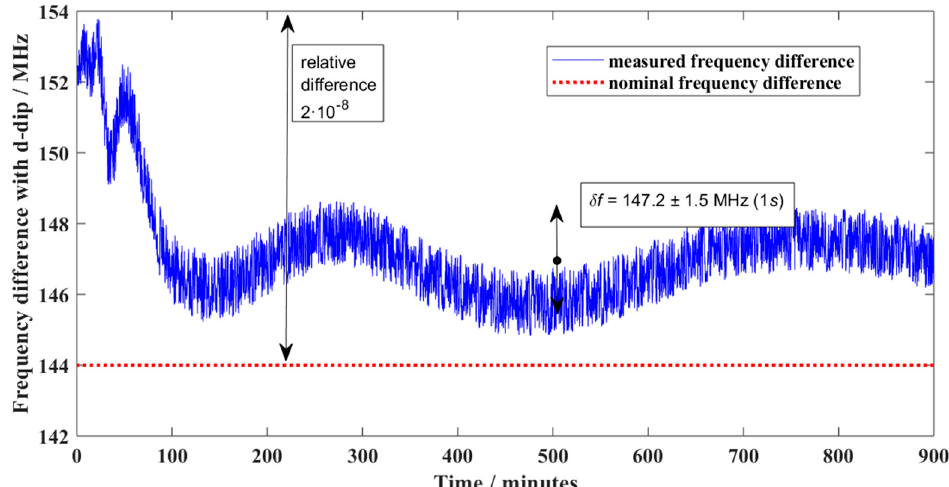
Figure 3. Typical result of a beat-measurement between an iodine stabilized laser and a laser used in a displacement laser interferometer system. The uncertainty of the iodine stabilized reference laser is better than 0.05 Mhz; this corresponds to a thin horizontal line on this scale; its stability is even better.